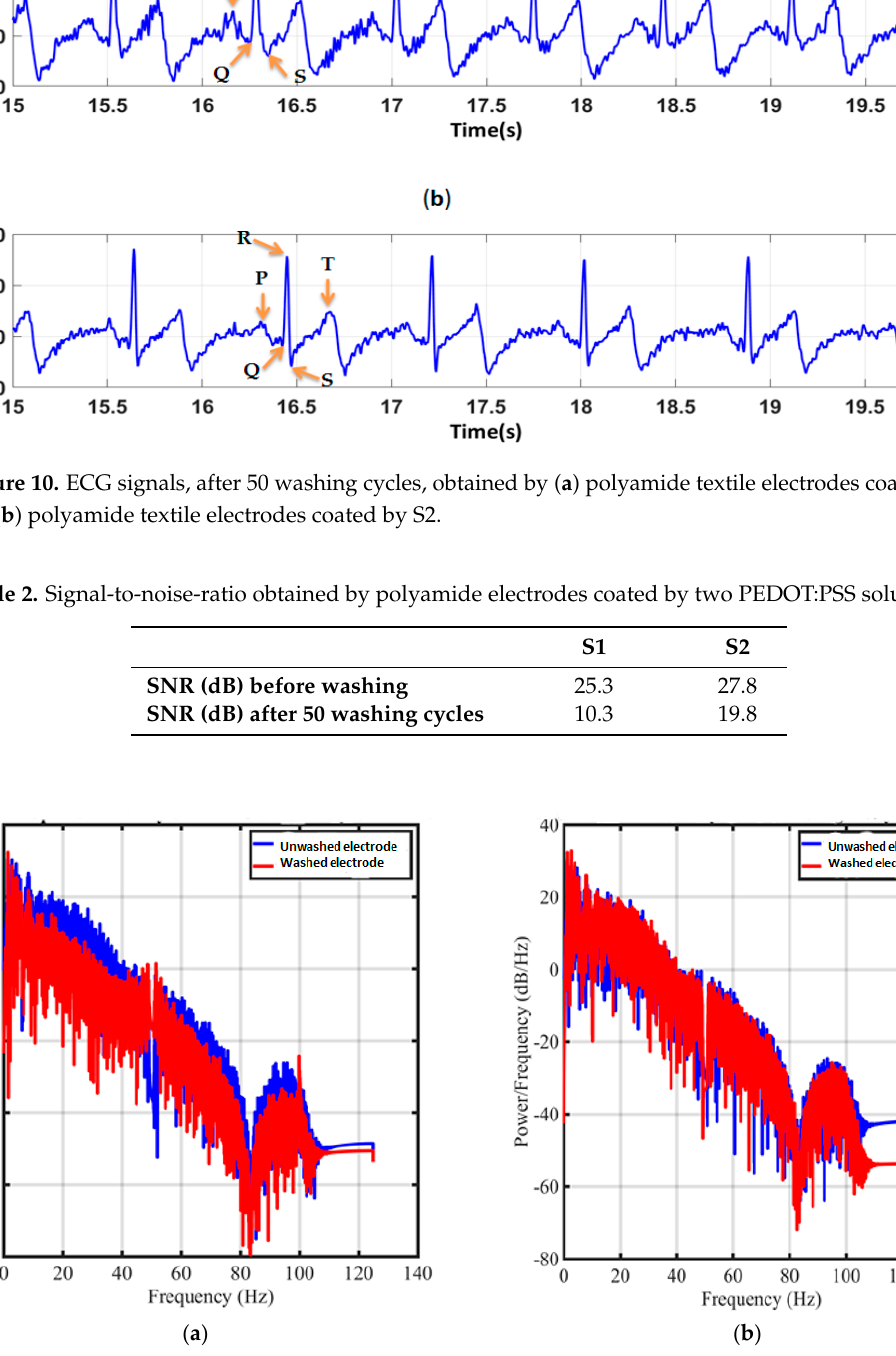
Figure 11. Power spectral densities of ECG signal measured from electrodes made by ( a ) S1 solution; ( b ) S2 solution.